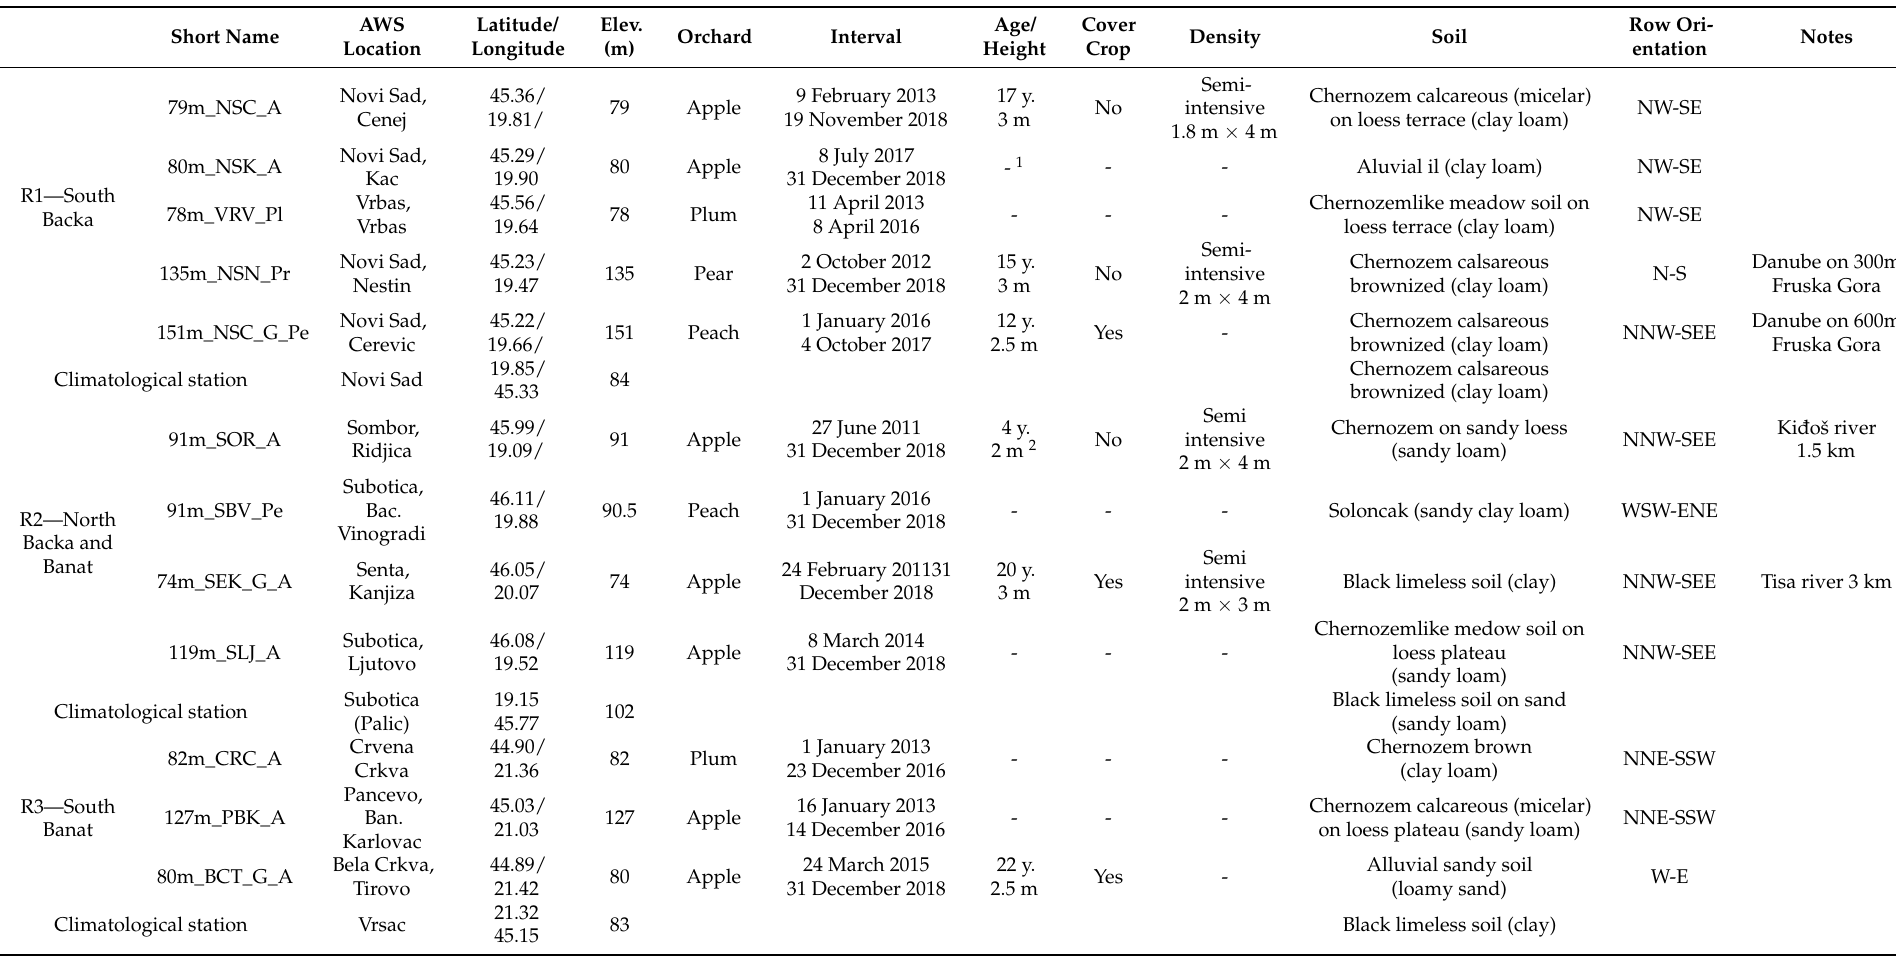
Table 1. List of AWSs and climatological stations used in the study. AWS is elevation + short location + cover crop + orchard type to provide information for comparison. The closest city was named as the climatological